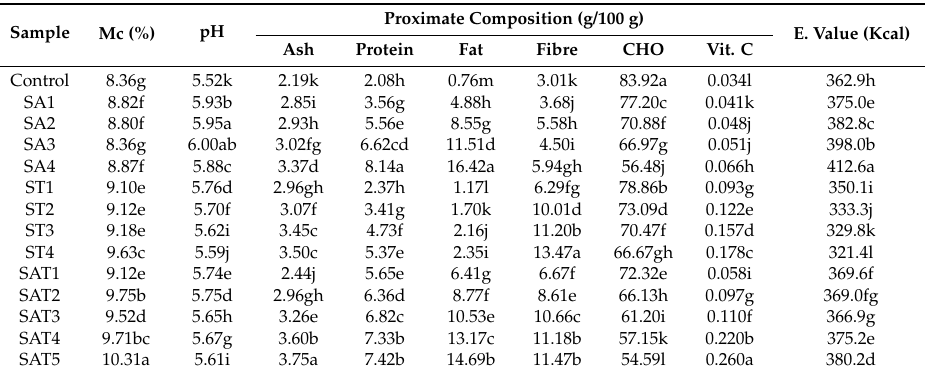
Table 3. Proximate, Vitamin C, pH, and Energy value of the composite flour.